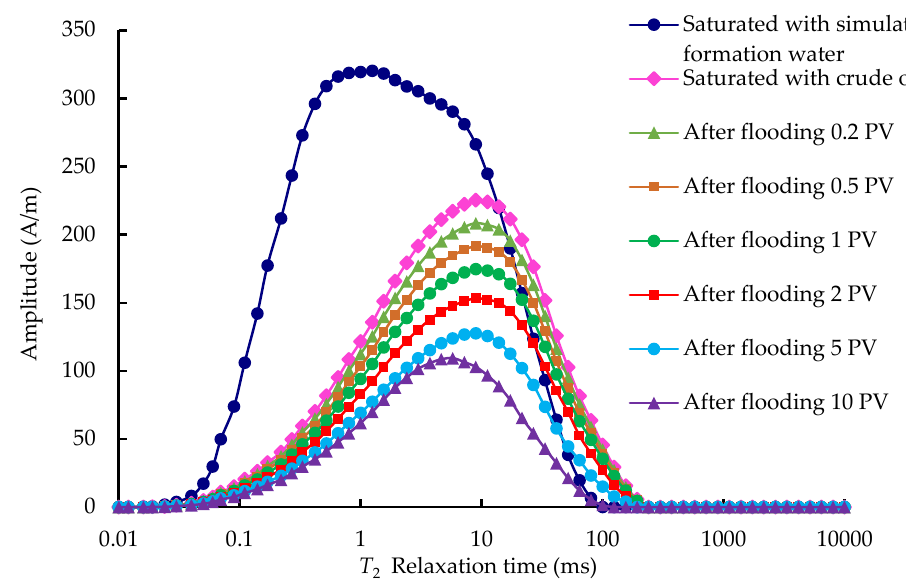
Figure 1. Nuclear magnetic resonance (NMR) T 2 relaxation time curves of a tight oil sandstone core.